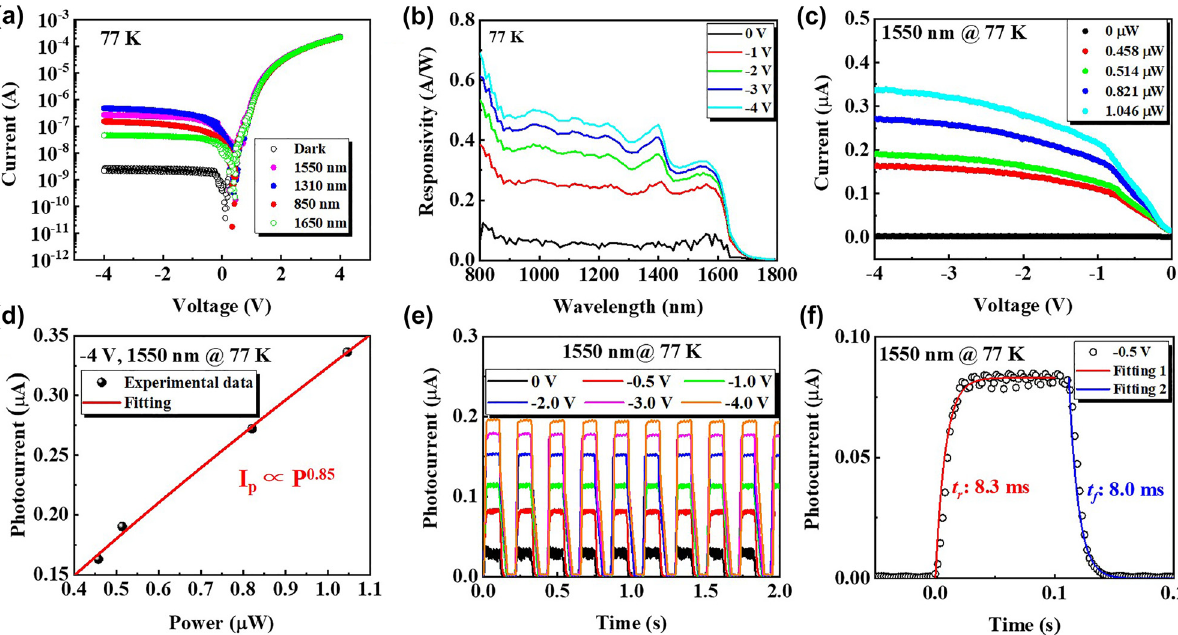
Figure 5: Photoresponse properties of the GeSn NW PD at 77 K. (a) Comparison of I – V curves of the GeSn NW PD under illumination of light with wavelengths of 850, 1310, 1550 and 1650 nm at 77 K. (b) Response spectra of the GeSn NW PD under biases of − 4 V–0 V at 77 K. (c) Reverse I – V curves of GeSn NW PD at 77 K under 1550 nm light illumination with powers of 0 μ W (dark) to 1.046 μ W. (d) Dependence of photocurrent of the GeSn NW PD under 1550 nm light illumination on incident light power under − 4 V at 77 K. (e) Real-time photo response of the GeSn NW PD under 1550 nm light illumination with a power of 0.514 μ W under reverse biases of 0 V to − 4 V. (f) Temporal response of the GeSn NW PD under single pulse of 1550 nm light with a power of 0.514 μ W at 77 K under − 0.5